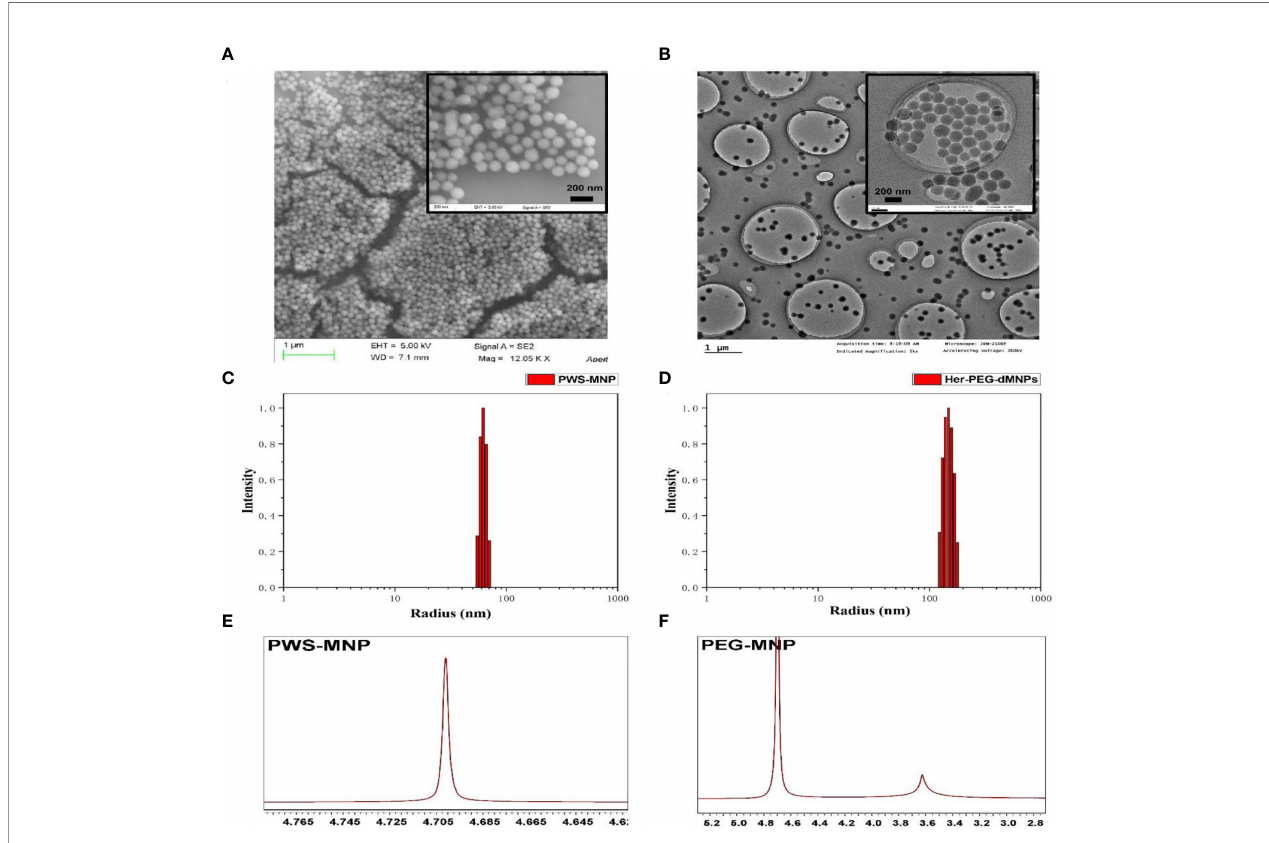
FIGURE 1 | Characterization of the nanoprobe. (A) SEM of dMNPs with a scale bar = 1 µm, and Her-PEG-dMNPs (reduction) with a scale bar = 200 nm. (B) TEM of dMNPs and Her-PEG-dMNPs (reduction) with scale bars = 1 µm and 200 nm. Hydrodynamic size distribution graphs of PWS-dMNP (C) and Her-PEG-dMNPs (D) . (E) 1 H-NMR spectra of PWS-MNP and (F) PEG-dMNPs in D 2